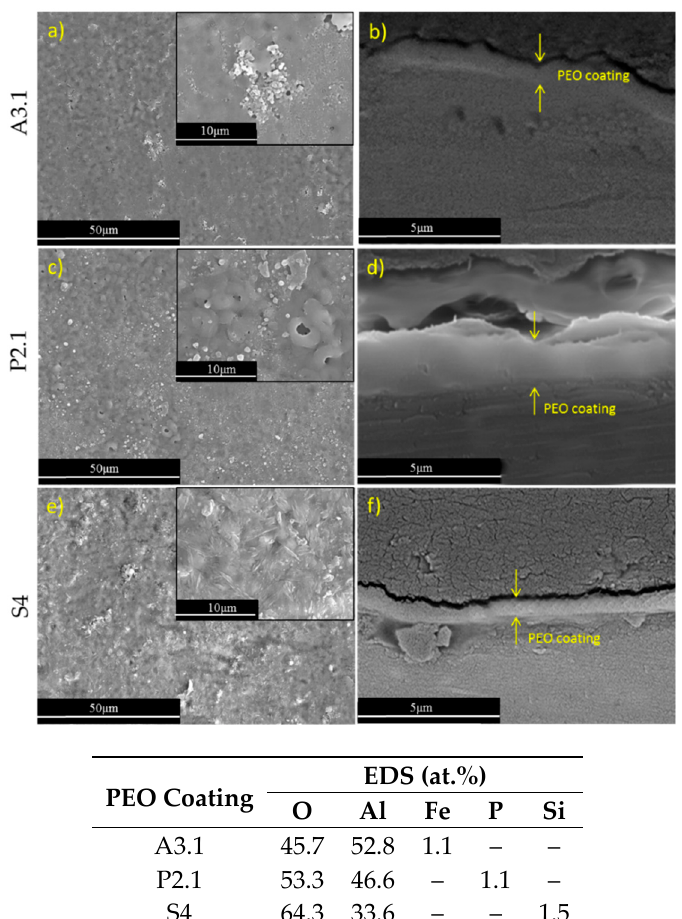
Figure 3. Planar view ( a , c , e ) and cross-section view ( b , d , f ) of secondary electron images of the PEO coatings (A3.1, P2.1, S4), respectively. EDS analysis was performed on the areas corresponding to the planar views of the coatings.